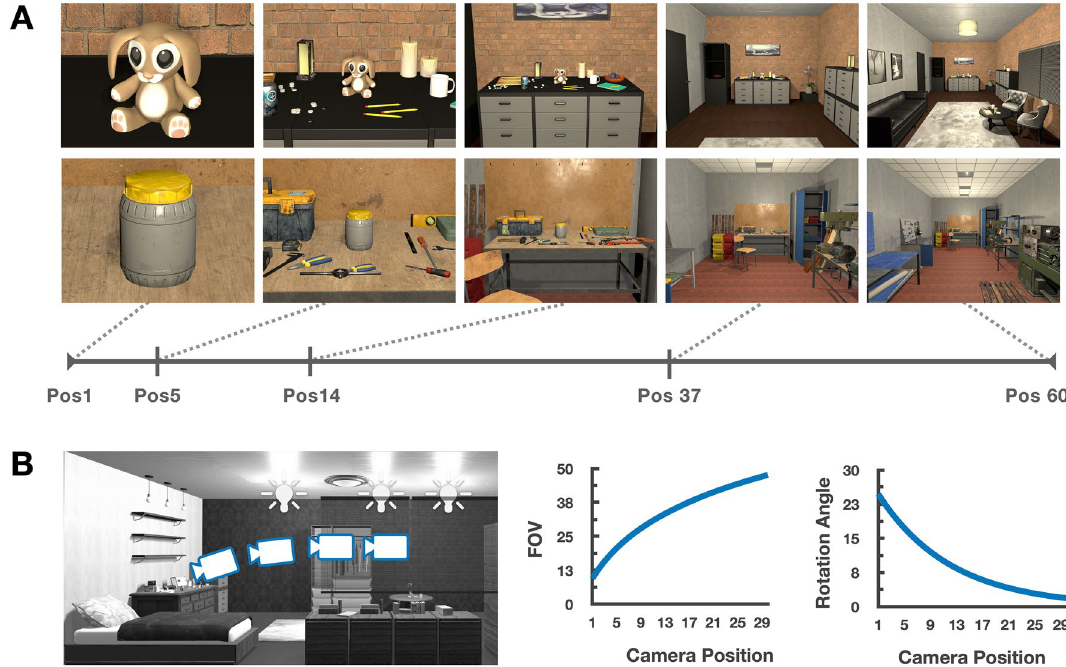
Figure 1. Stimuli. ( A ) Example images taken from two different environments (each row). Within each environment, we varied the the camera position along 15 log-scaled points, from a close-up object view (Position 1) up to a full-scene view (Position 60). Here, 5 positions are shown for illustration purposes. ( B ) Two camera parameters were systematically varied with the change of camera position. First, the field of view (FOV) was smallest at the closest view, then increased logarithmically as the camera moved toward the farthest view. Second, the rotation angle was downward at the closest view, then gradually adjusted upward, simulating a person looking at the central object from different positions in the